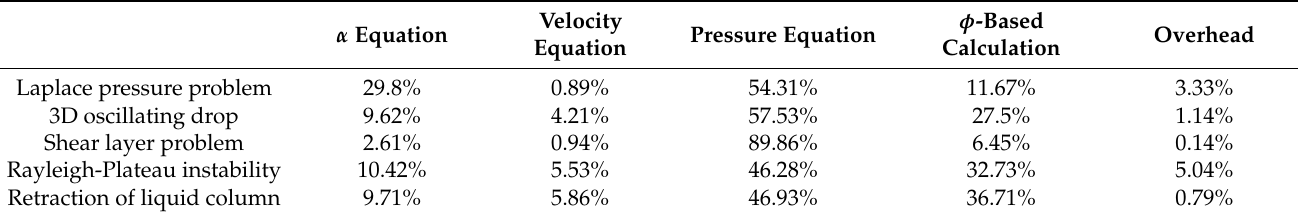
Table 6. Distribution of computational costs as a percentage of total costs. Quantities presented are average values corresponding to 3500 time